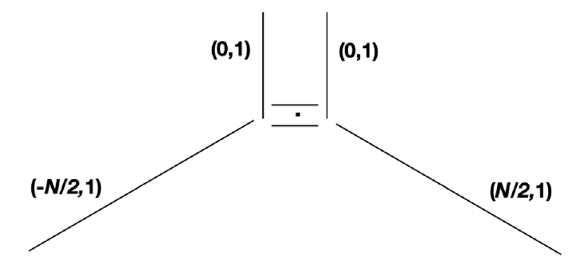
Figure 3 . ( p, q ) web for N = 1 SU( N/ 2) gauge theory with a Chern-Simons term at level k = N/ 2 .